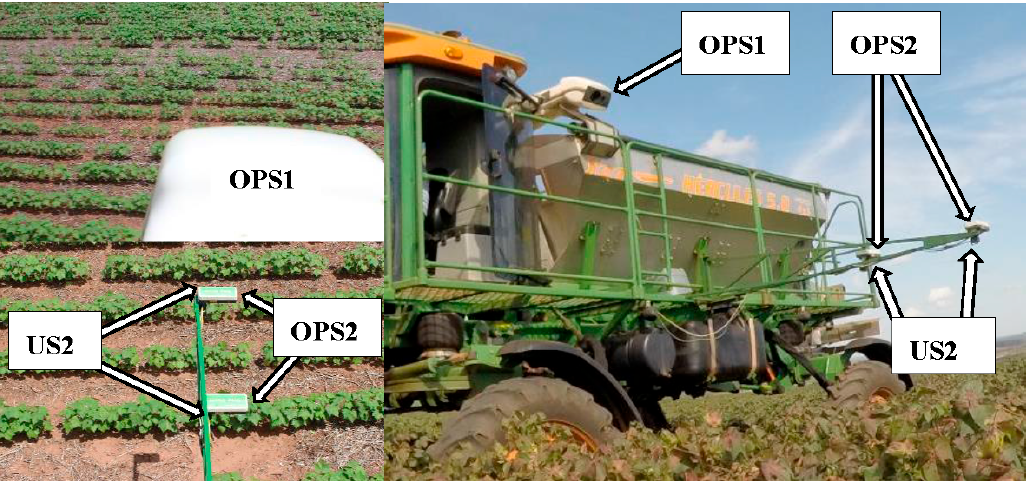
Figure 1. Approximate view from each sensor position and mounting points in the high clearance vehicle used to move the sensors through the field. Pictures from 2014/2015 crop season of narrow row cotton cultivated in a sandy loam Quartzipsamment in Mato Grosso state.